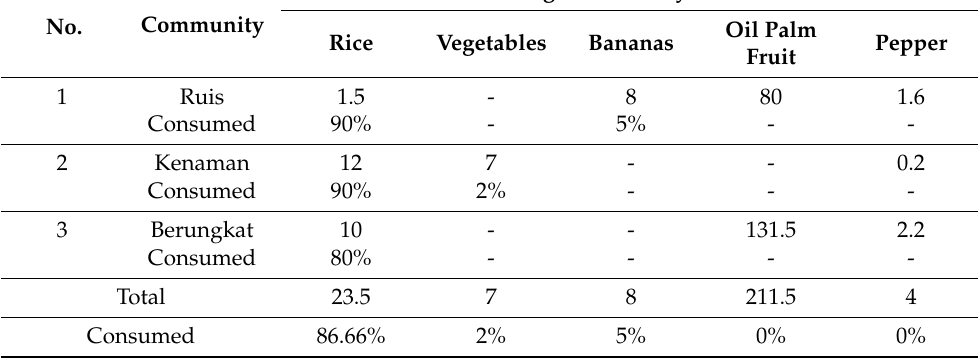
Table 8. Estimation of additional farming productivity (ton/year) after the implementation of the KMP